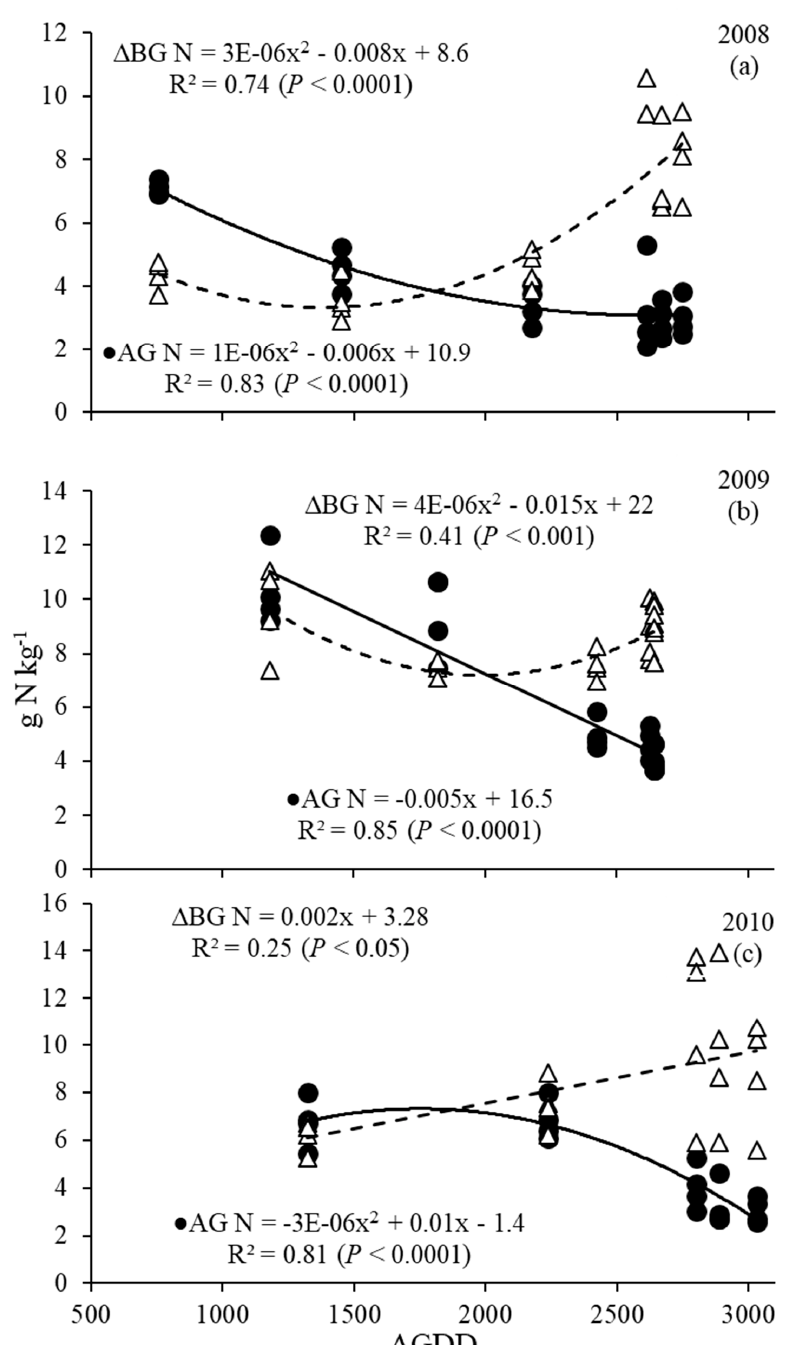
Figure 4. Switchgrass above (AG) and belowground (BG) nitrogen concentration (g N kg − 1 ) as a function of AGDD (accumulated growing degree days) harvests in 2008, 2009 and